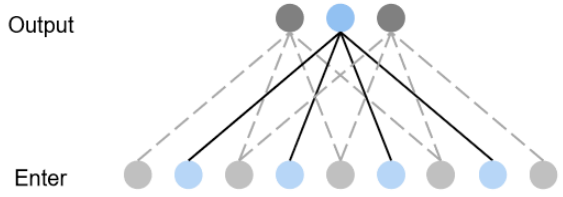
Figure 2. Dilated Convolution. Figure 2. Dilated